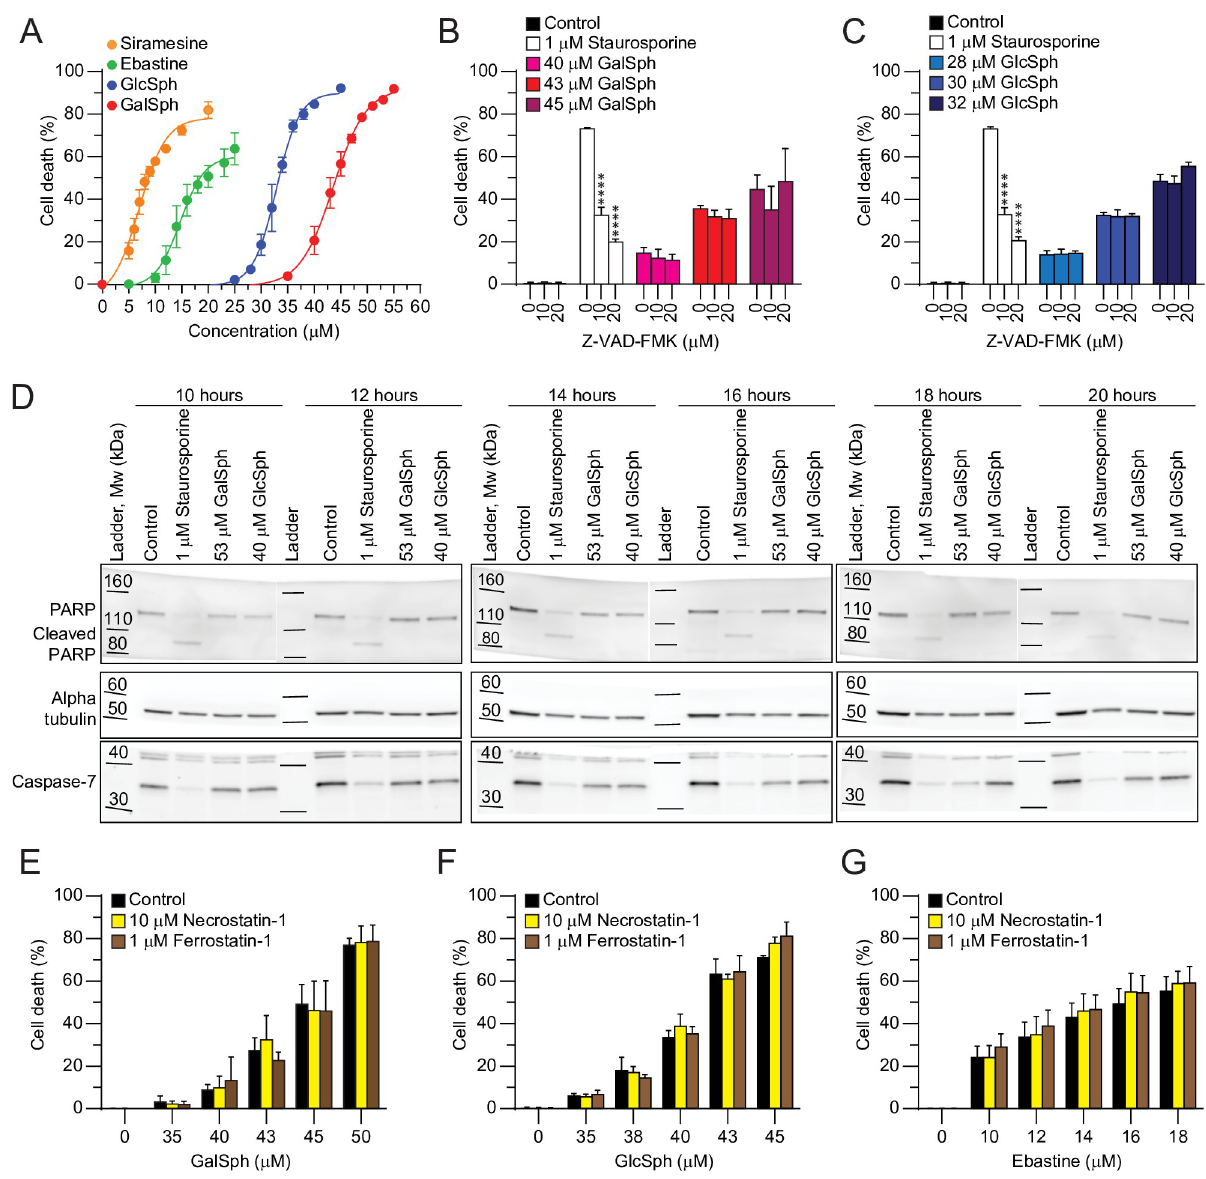
Fig 1. GalSph- and GlcSph-induced death of MCF7 cells is independent of apoptosis, necroptosis and ferroptosis. (A) Death of MCF7 cells treated for 48 hours with indicated concentrations of GalSph, GlcSph, ebastine or siramesine was determined by propidium iodine and Hoechst-33342 staining employing Celigo Imaging Cytometer. Connecting lines represent non-linear fit with R 2 > 0.99 for each treatment. (B, C) Death of MCF7 cells treated for 48 hours with indicated concentrations of GalSph (B) or GlcSph (C) after 1 hour pre-treatment with indicated concentrations of Z-VAD-FMK was determined as in (A). Staurosporine served as a positive control for apoptotic cell death. (D) Representative Western blots of PARP, caspase-7, and alpha tubulin (loading control) in lysates of MCF7 cells treated for indicated times with GalSph or GlcSph at concentrations corresponding to their LC90 values. Staurosporine served as a positive control for apoptotic cell death. (E-G) Death of MCF7 cells treated for 48 hours with indicated concentrations of GalSph (D), GlcSph (E), or ebastine (F) after 1 hour pre-treatment with indicated concentrations of necrostatin-1 or ferrostatin-1 was determined as in (A). Error bars, SD of three independent experiments. � , P < 0.05; �� , P < 0.01; ��� , P < 0.001; ���� , P < 0.0001 as analyzed by two-way ANOVA followed by Dunnett’s (B-C) or Sidak’s (E-G) multiple comparisons tests. interacting serine/threonine-protein kinase 1, and ferrostatin-1 that inhibits ferroptosis by trapping peroxyl radicals (Fig 1E–1G) [48, 49]. Taken together, these data suggest that GalSph and GlcSph activate a cell death pathway dis- tinct from apoptosis, necroptosis, and ferroptosis in MCF7 cells.